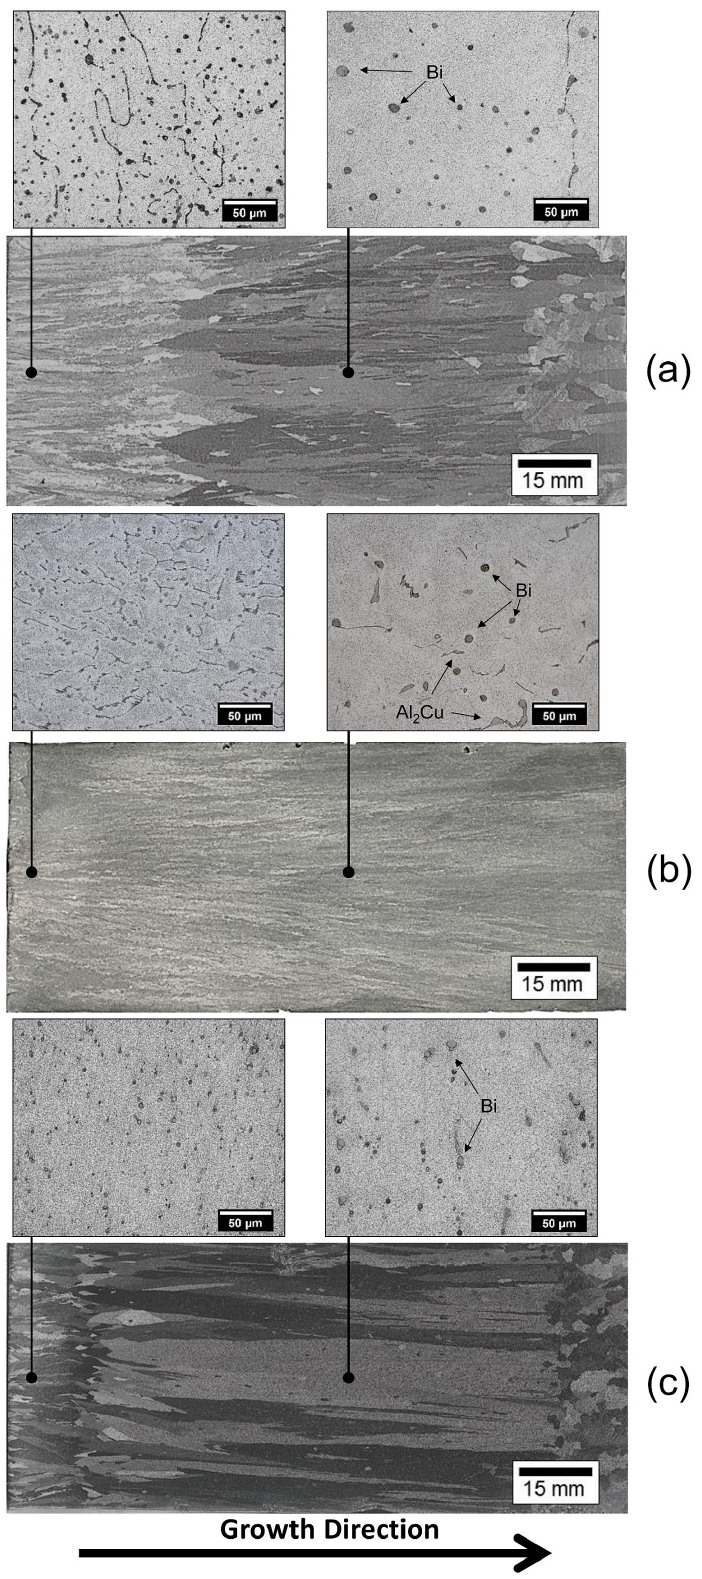
Figure 5. Macrostructures and respective microstructures at 2 points along the length of the direc- tionally solidified (DS) ( a ) Al-3.2 wt.% Bi, ( b ) Al-3.2 wt.% Bi-3.0 wt.% Cu, and ( c ) Al-3.2 wt.% Bi-3.0 wt.% Zn alloys castings.